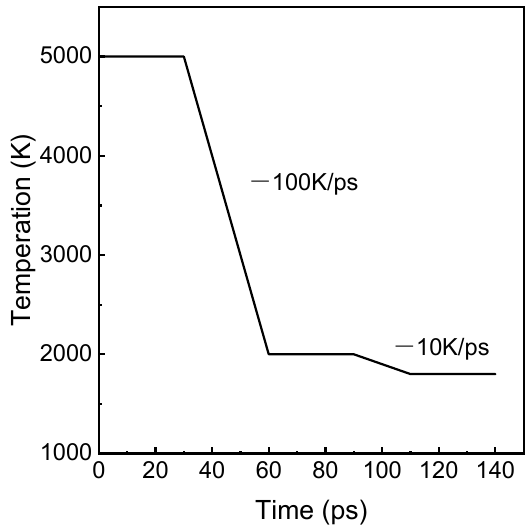
Figure 2. Computing process of simulation. Table 2. Composition of red mud and number of atoms.